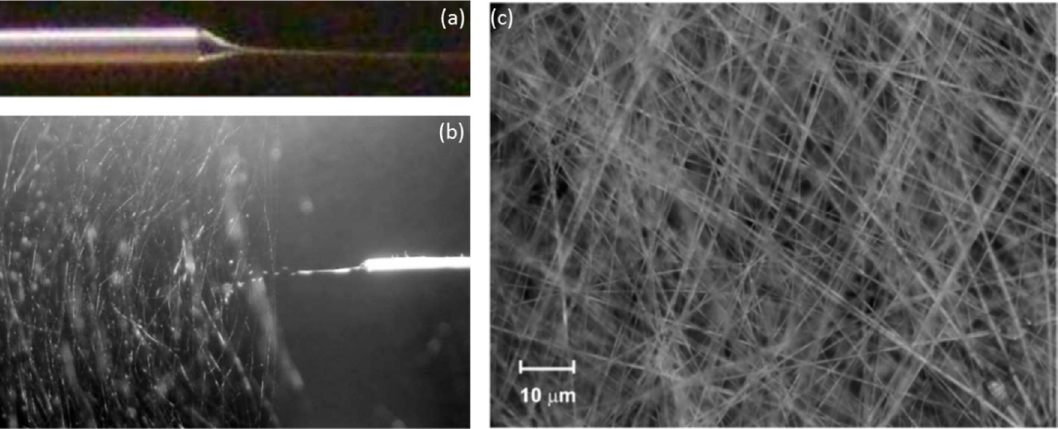
Figure 38. ( a ) Detail of the needle where the jet emerges and ( b ) the nanofibre formation, describing a helix path; ( c ) SEM image of the nanoweb once it is deposited onto a glass slide. Images reprinted from [171] with the permission of IEEE.